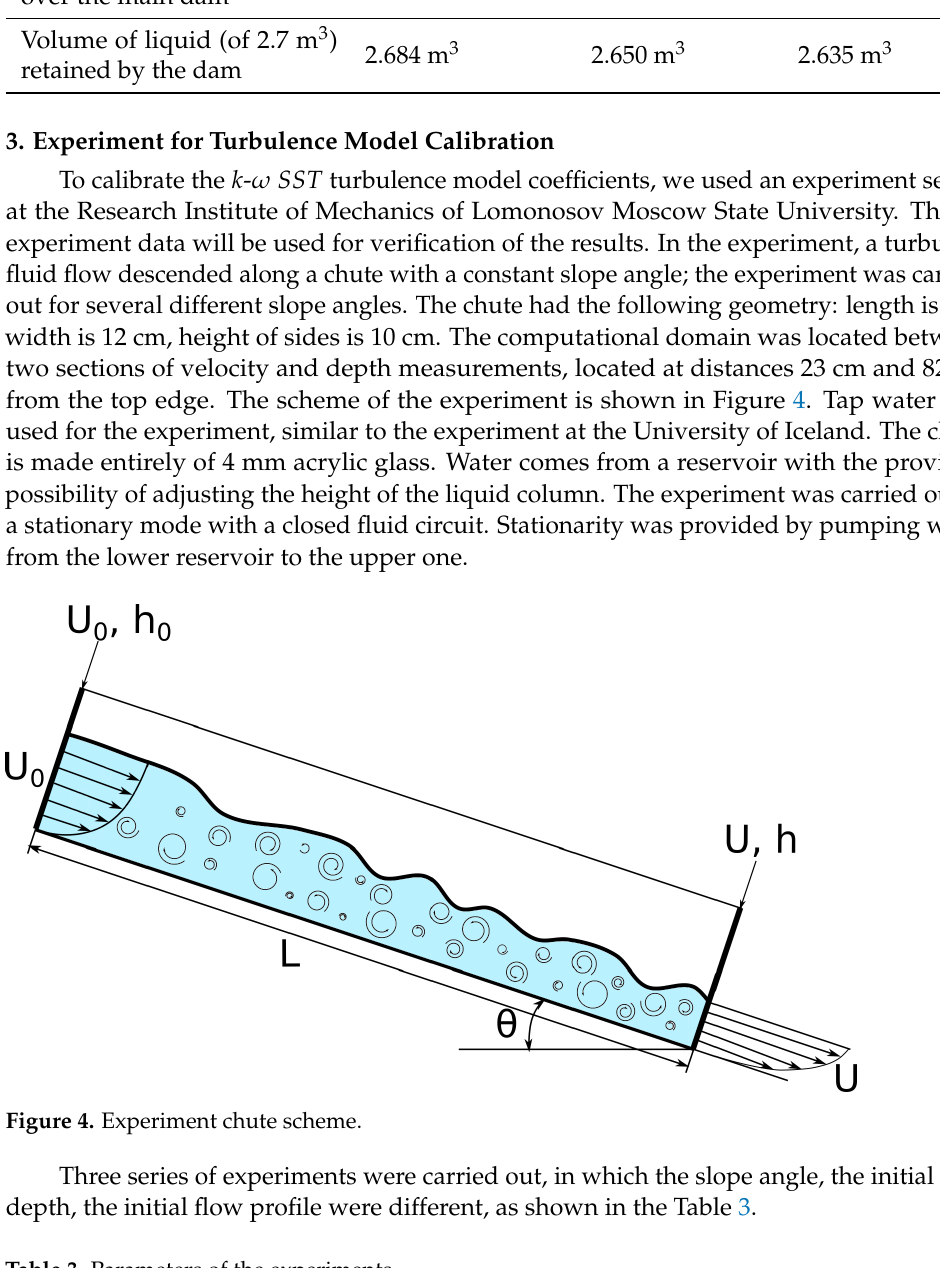
Table 3. Parameters of the